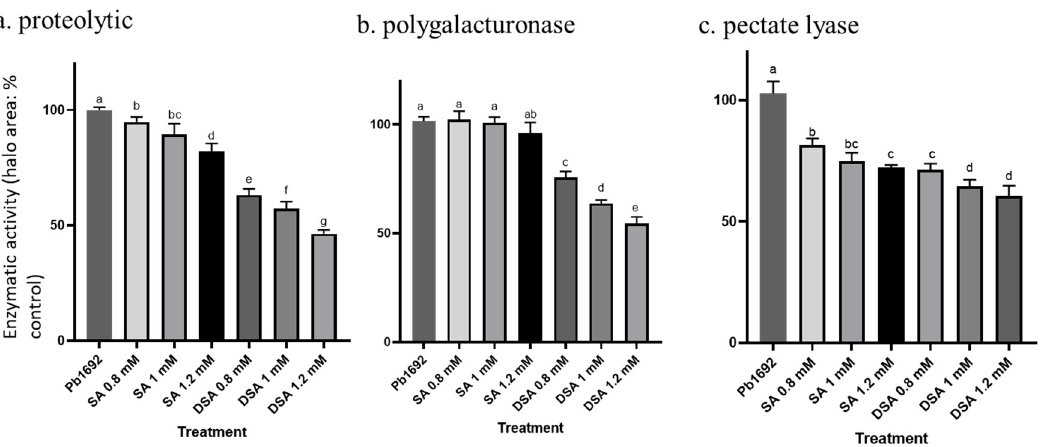
Figure 6. ( a ) Intensity of the luminescence of Escherichia coli pSB401 in response to supernatants of Pectobacterium brasilense Pb1692 grown with nonlethal concentrations (0.4–1 mM) of DSA or SA or DDW. Luminescence (250 ms) and absorbance (600 nm) were measured every 30 min for 18 h and the relative luminescence (RLU = LU/OD 600 nm ) was calculated. E. coli pSB401 grown in the absence of supernatants of Pb1692 was used as a control. ( b ) Growth of Escherichia coli pSB401 in the presence of different concentration of DSA and SA. Absorbance (600 nm) was measured every 30 min for 18 h. Each data point represents the mean ± SE of 8 replicates per treatment of one experiment, representative of 2 independent experiments with similar results. OD, optical density; LU, light units; RLU, relative light units.